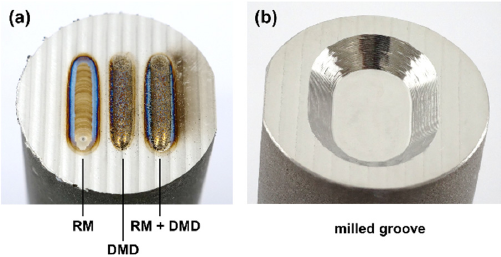
Figure 4. ( a ) Single tracks deposited in face-milled substrates and ( b ) groove geometry after machining.